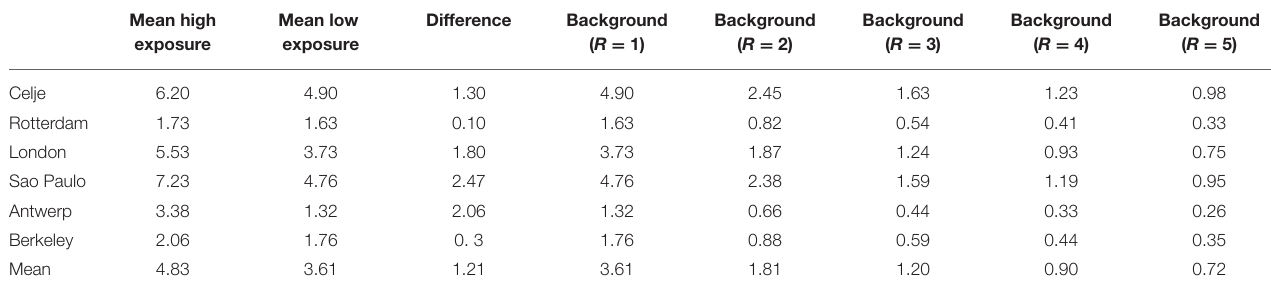
TABLE 2 | The reduction in exposure to pollutants by taking an alternative route in cycling (R = ratio of mean low exposure route to background, the unit for all numbers is µ g/ m 3 ). Mean high exposure